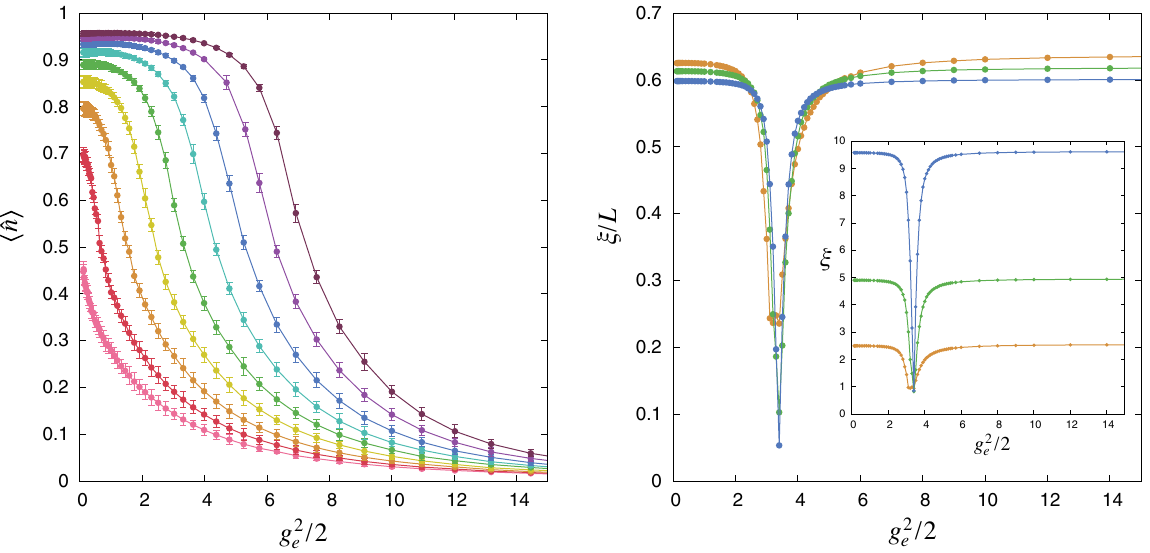
FIG. 4. Left panel: profiles of the matter density as a function of the electric-field coupling for different values of negative mass obtained by vertically cutting the color plot in Fig. 3. From bottom (pink circles) to top (purple circles), the mass takes the values m ∈ f − 0 . 01 ; − 0 . 5 ; − 1 ; − 1 . 5 ; − 2 ; − 2 . 5 ; − 3 ; − 3 . 5 ; − 4 g . Right panel: correlation length, in the ground state for m ¼ − 2 and varying the electric coupling, extracted from the density-density correlation function as explained in the main text. Different colors represent different sizes: 4 × 4 (orange), 8 × 8 (green), and 16 × 16